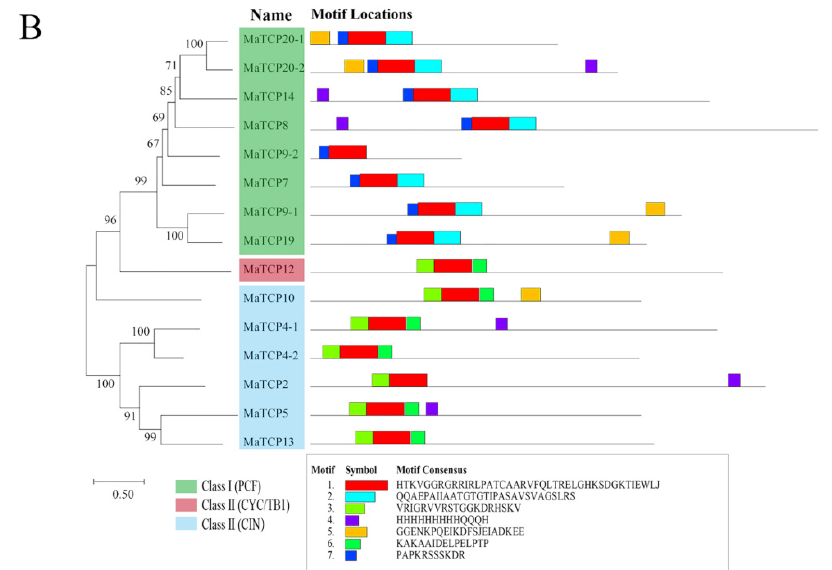
Figure 1. The phylogenetic and protein structure analyses of MaTCP family members. ( A ) Neighbor-joining phylogenetic tree of TCP transcription factors in M. alba , P. euphratica , and A. thaliana. Three different colors were designated as three subclades of PCF, CYC/TB1, and CIN. ( B ) Conserved motifs of MaTCP proteins. Different motifs were shown by different colors numbered 1–7.